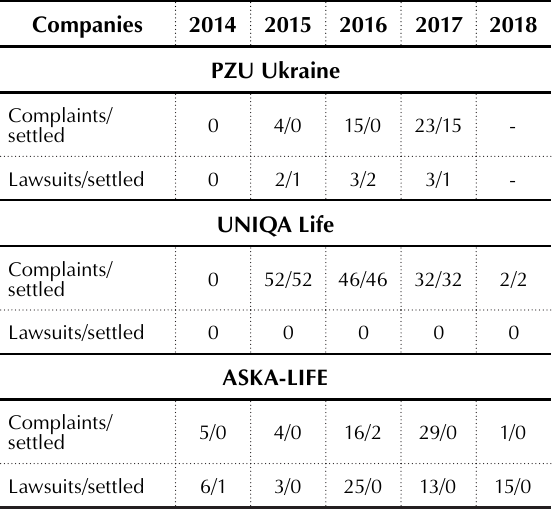
Table 6. Current accounts payable (year-end),